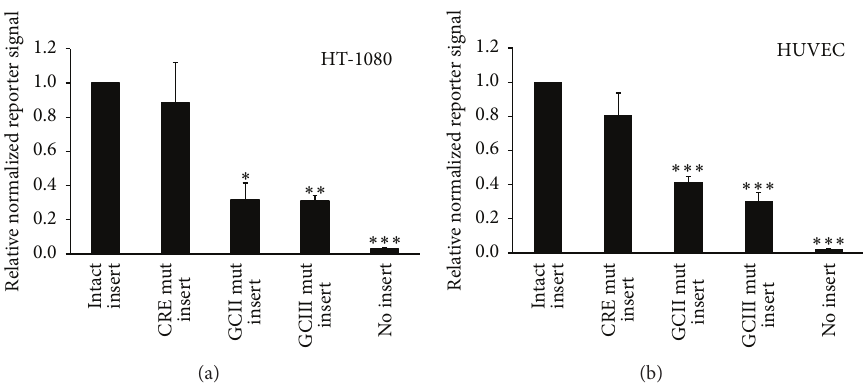
Figure 2: Basal signal levels of t-PA reporter construct and its dependence on proximal GC boxes. HT-1080 (a) and HUVEC (b) cells were cotransfected with a firefly luciferase construct containing different variants of a 318 bp insert of the t-PA proximal promoter and a SV40 driven pGL4.73 renilla luciferase control vector. Firefly luciferase signals were normalized to renilla luciferase. The figures show relative basal signal levels in unstimulated reporter constructs and mean values of three (HT-1080) and four (HUVEC) independent experiments. The variants of the t-PA insert were unmutated (intact), CRE mutated, GC box II mutated, GC box III mutated, and no insert (empty pGL4.10 vector). Statistical evaluation was performed using paired Student’s 𝑡 -test and is made relative to constructs with intact insert. ∗ 𝑝 < 0.05 , ∗∗ 𝑝 < 0.01 , and ∗∗∗ 𝑝 < 0.001 .